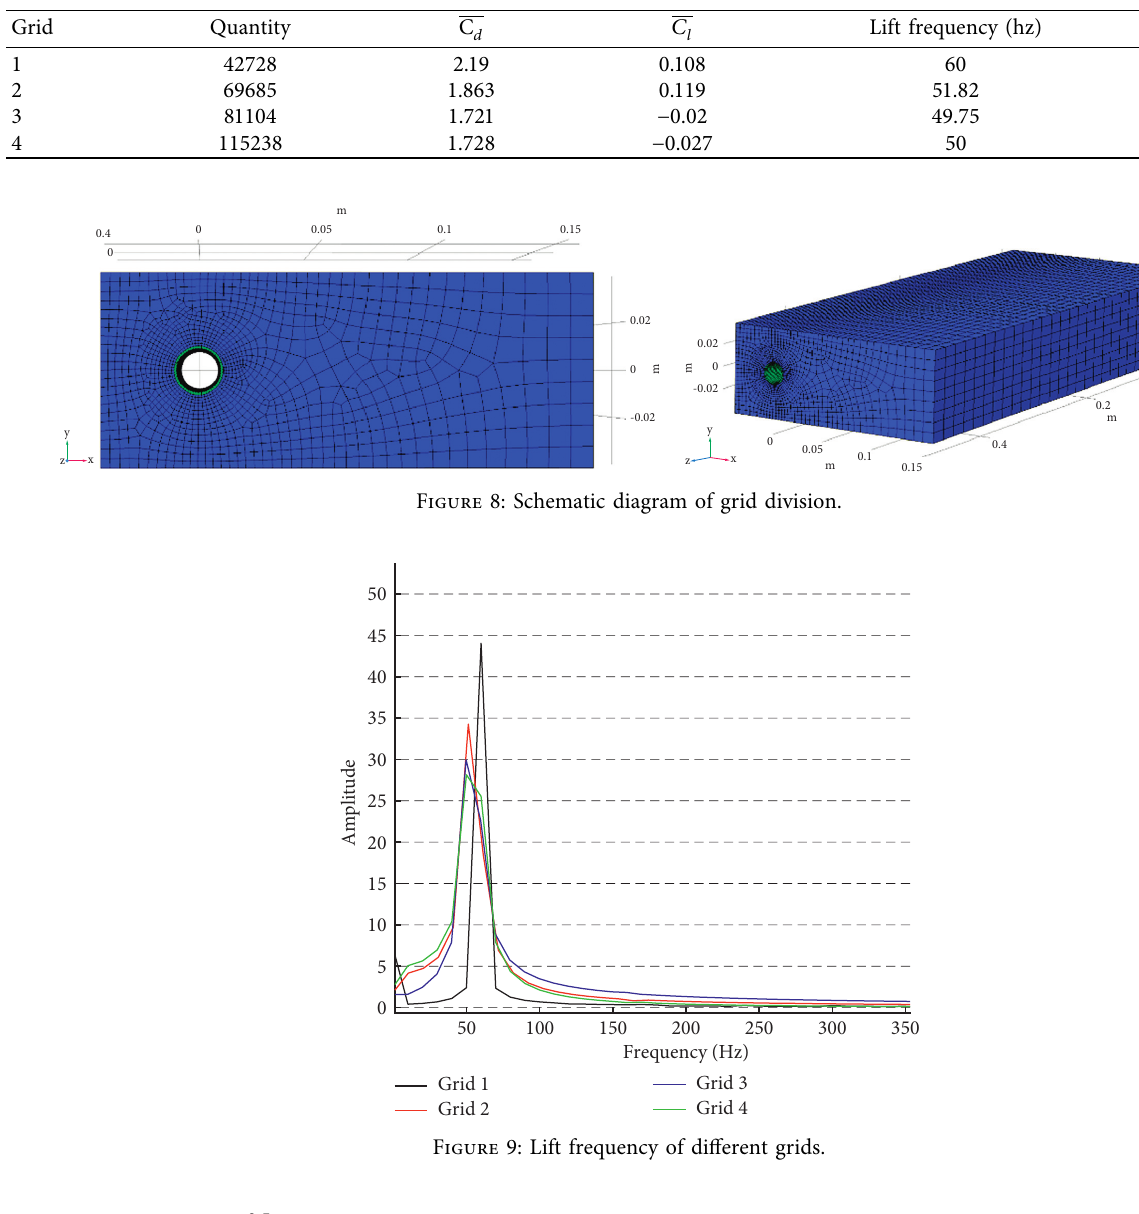
Table 5: Results of grid independency.